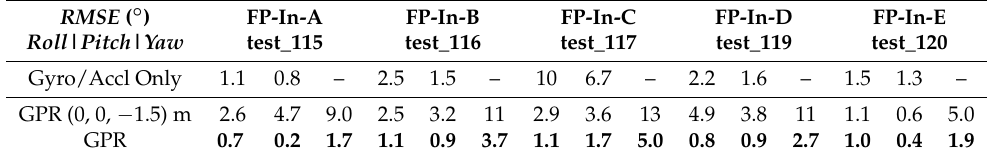
Table 5. RMSE for each indoor experimental test using different magnetic field reference sources. The first row excludes magnetometer data. For each test, the three columns show the RMSE for roll, pitch, and yaw, respectively, in